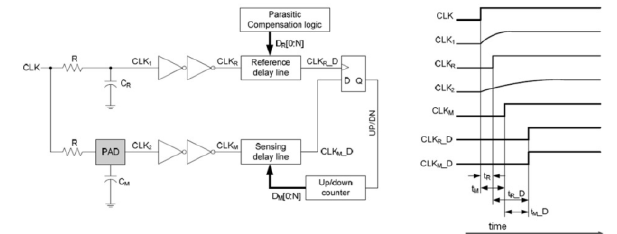
Fig. 3. Diagram of the acquisition technique blocks used for FUJITSU FMA1127 and the timing signals for the touch event detection.